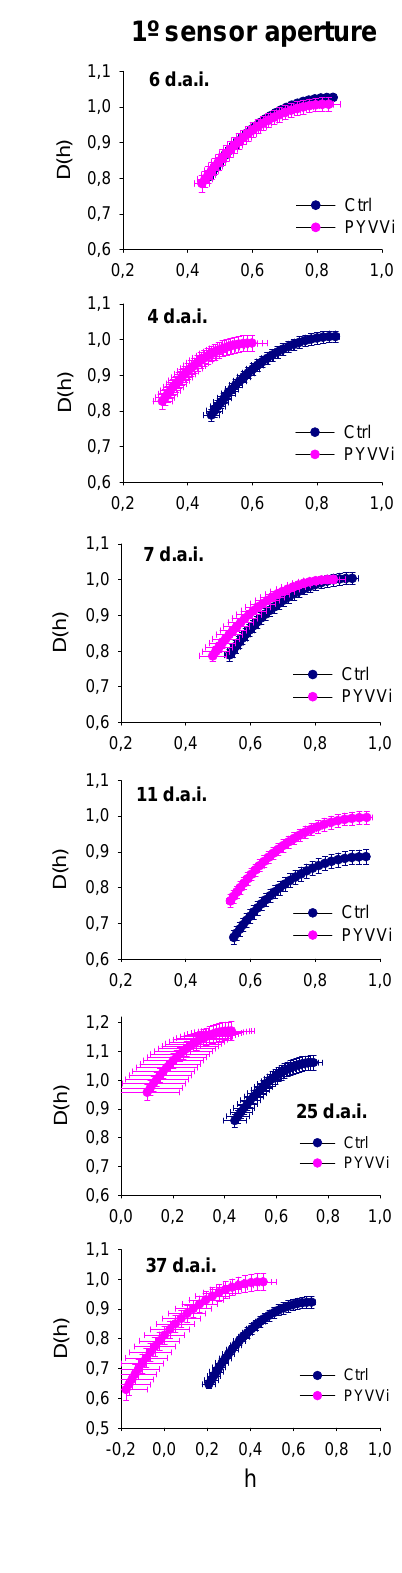
Figure 5. Multifractal singularity spectra of plants. The first experiment was with a sensor aperture of 25° ( left ) and the second experiment was with a sensor aperture of 1° ( right